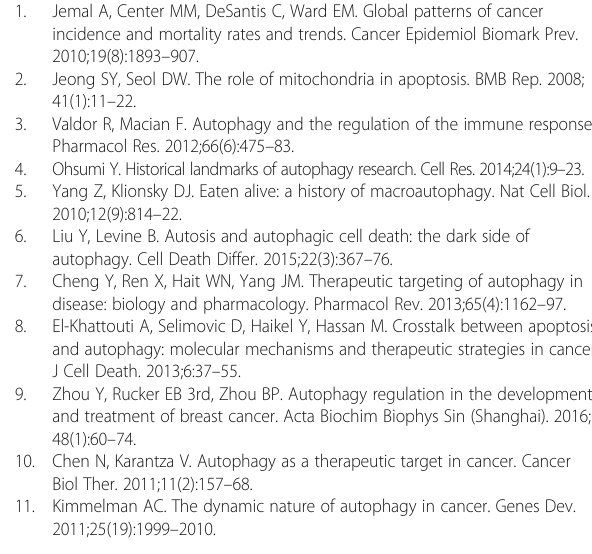
Additional file 1: Figure S1. Ethanol extracts of Chrysanthemum zawadskii Herbich (ECZ) induced reactive oxygen species (ROS)-mediated apoptosis and autophagy in human colon cancer HT-29 cells. (A) Apop- tosis induction. (B) N-Acetyl-L-cysteine (NAC) attenuated apoptosis in- duced by ECZ. (C) Detection of acidic vesicular organelles (AVOs). (D) Effects of NAC on autophagy. Cells were treated with various concentra- tions (100 – 300 μ g/ml) of ECZ for 24h and stained with annexin V/propi- dium iodide and 1 μ M acridine orange (AO) at 37°C in the dark for 20